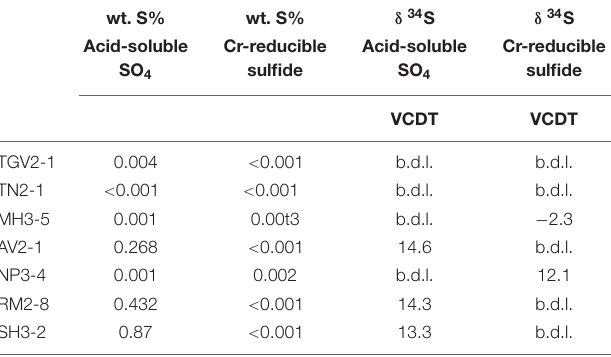
TABLE 5 | Sulfur sequential extractions on bulk sediment and δ 34 S values associated with each